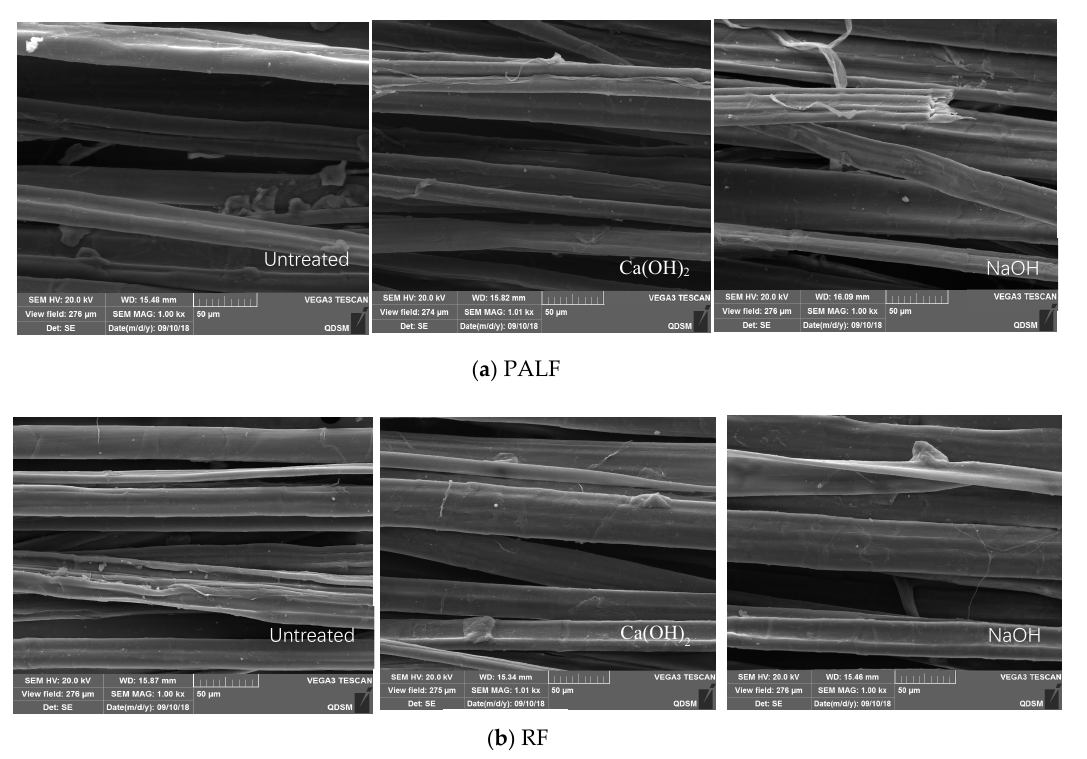
Figure 5. SEM images of PALF and RF before and after being soaked in Ca(OH) 2 and NaOH solutions with a pH value of 12.